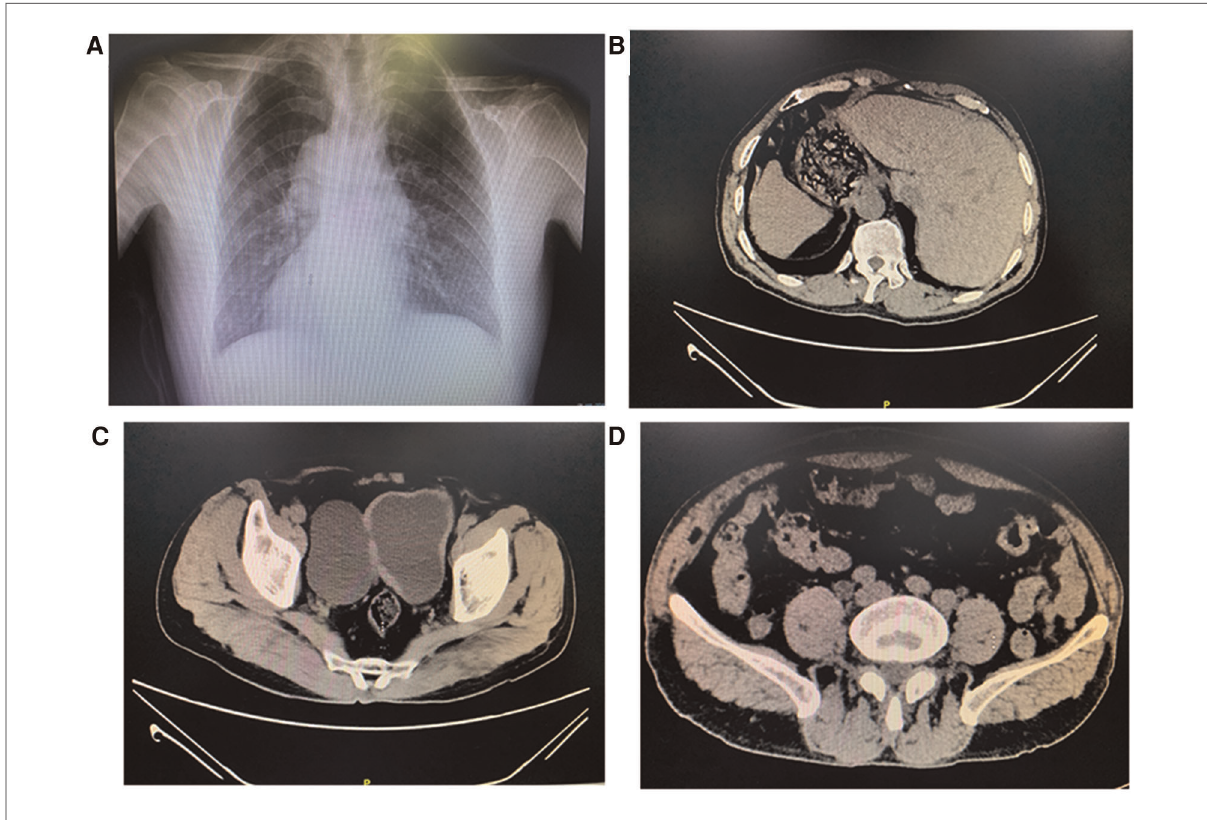
FIGURE 1 Chest radiographs show dextrocardia ( A ). Abnormal placement of stomach and liver ( B ). Computed tomography demonstrating a 78×50 mm diverticulum communicating with the bladder ( C ). Computed tomography demonstrating dilated hydronephrosis in the upper segment of the right-side ureteral ( D